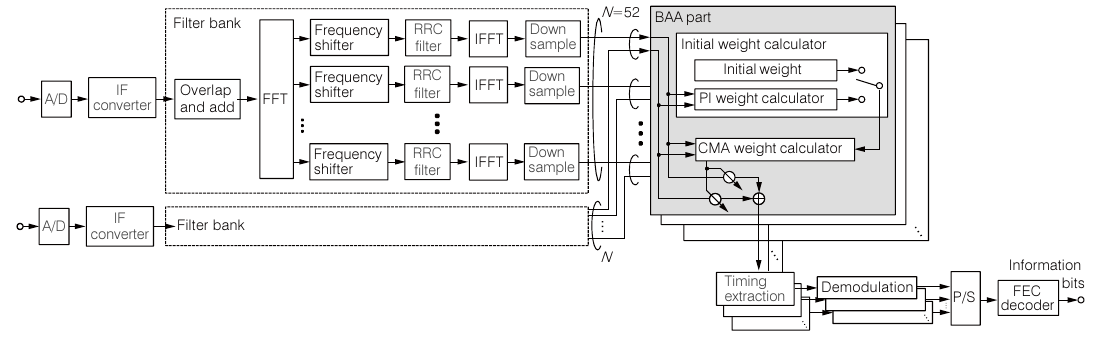
Figure 5. Receiver employing BAA. A/D: analog-to-digital; P/S: